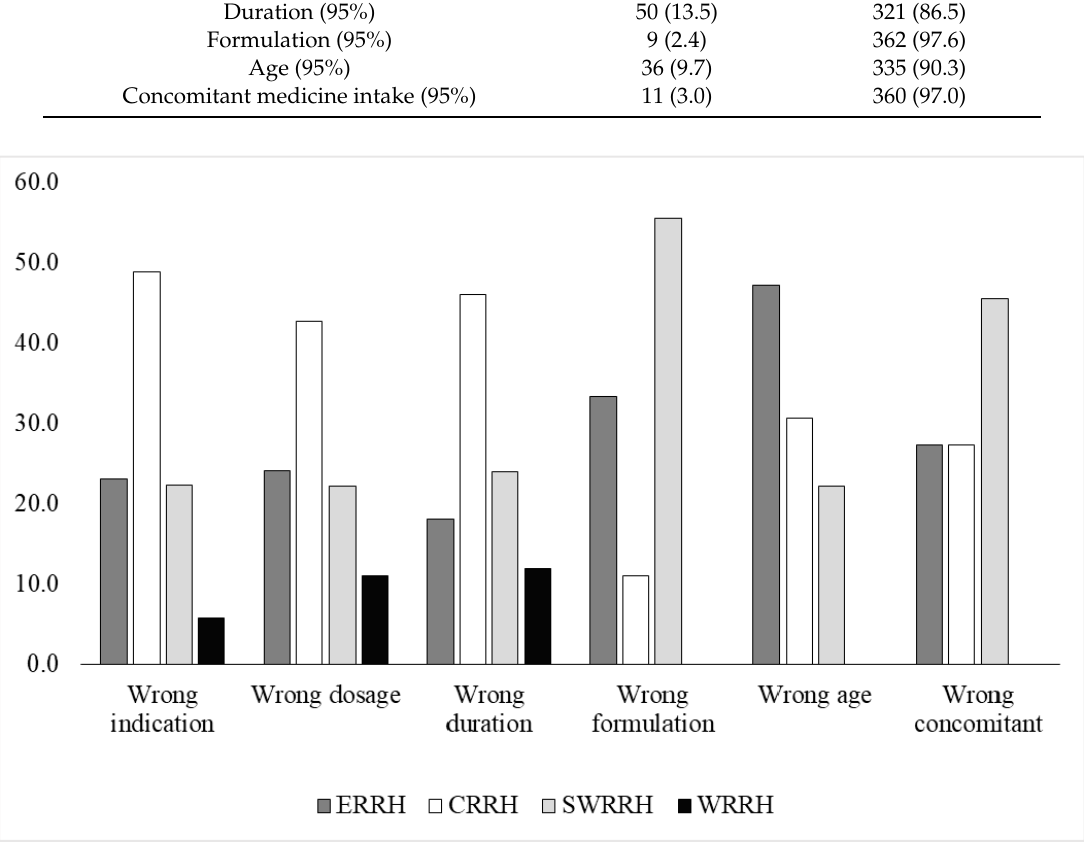
Figure 1. Proportion (%) of inappropriate prescriptions according to each WHO indicator (see Methods) and hospital: Eastern Regional Reference Hospital (ERRH), Central Regional Reference Hospital (CRRH), South Western Regional Reference Hospital (SWRRH), and Western Regional Reference Hospital (WRRH).